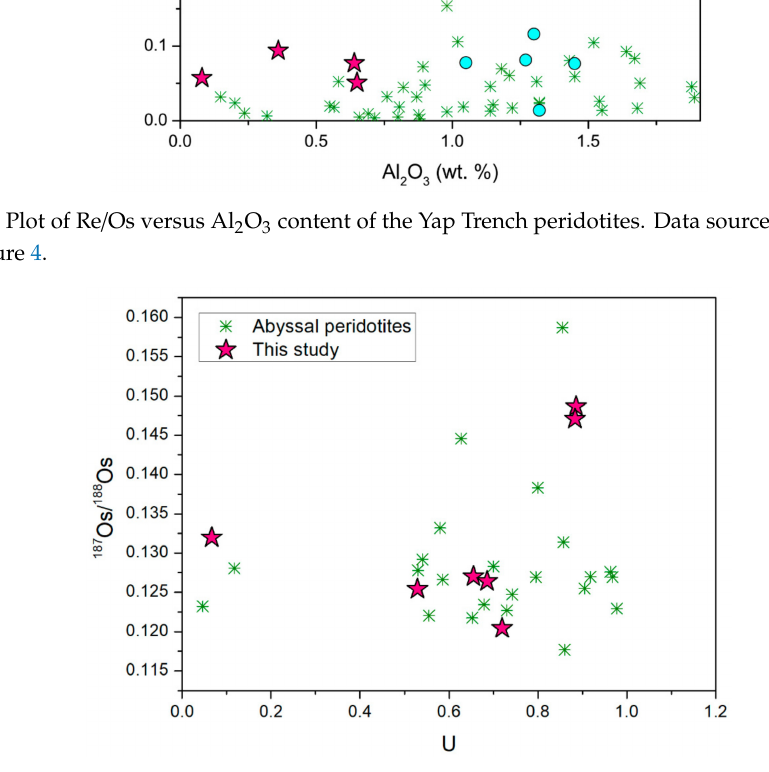
Figure 7. Plot of 187 Os / 188 Os versus U content of the Yap Trench peridotites. Data sources are the same as in Figure